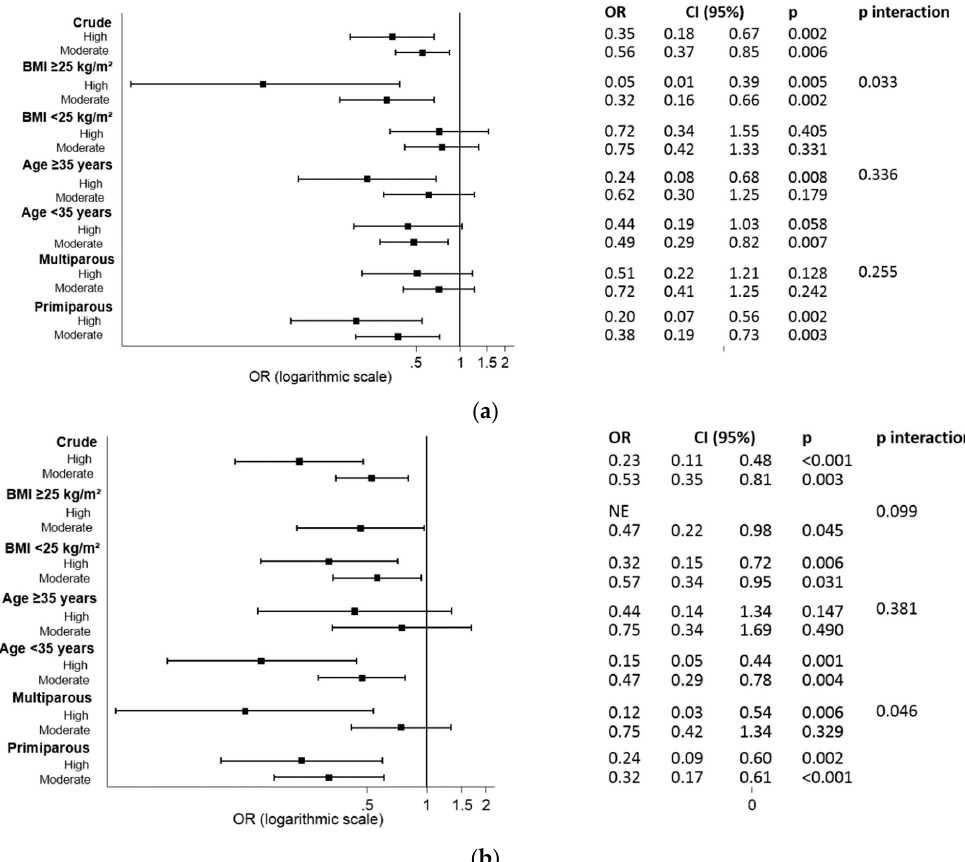
Figure 2. Logistic regression analysis by subgroups (crude and stratified by BMI, age, and parity) evaluating the degrees of adherence to the six food targets, and risk of ( a ) GDM; and ( b ) CMFC. p : logistic regression analysis comparing ORS with the reference group (low adherence